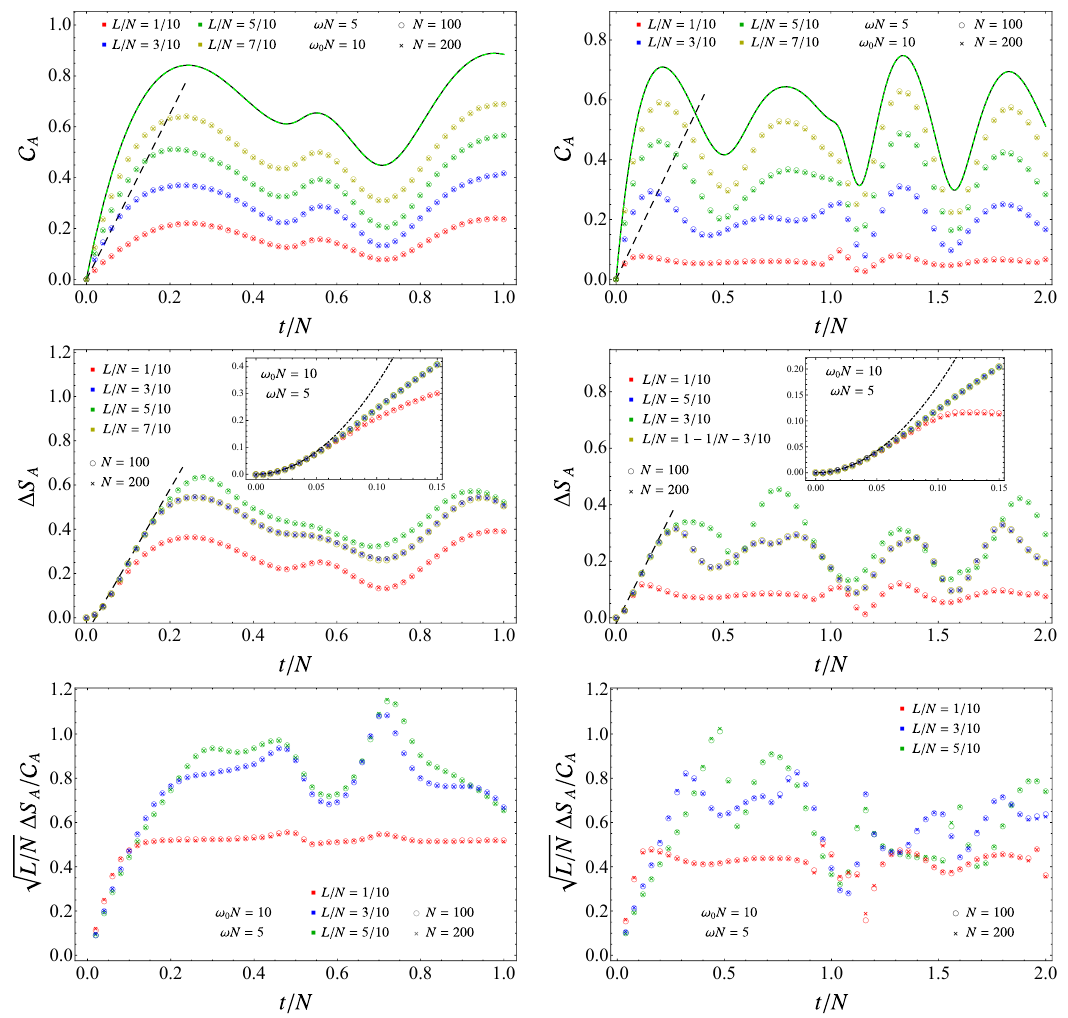
Figure 10 . Temporal evolution after the global quench with a gapped evolution Hamiltonian of C A in (4.6) (top panels), of ∆ S A in (4.7) (middle panels) and of for a block A made by L consecutive sites in harmonic chains with either PBC (left panels) or DBC (right panels) made by N sites (in the latter case A is adjacent to a boundary of the segment). When L = N , the complexity (3.7) is shown for N = 100 (solid black lines) and N = 200 (dashed green